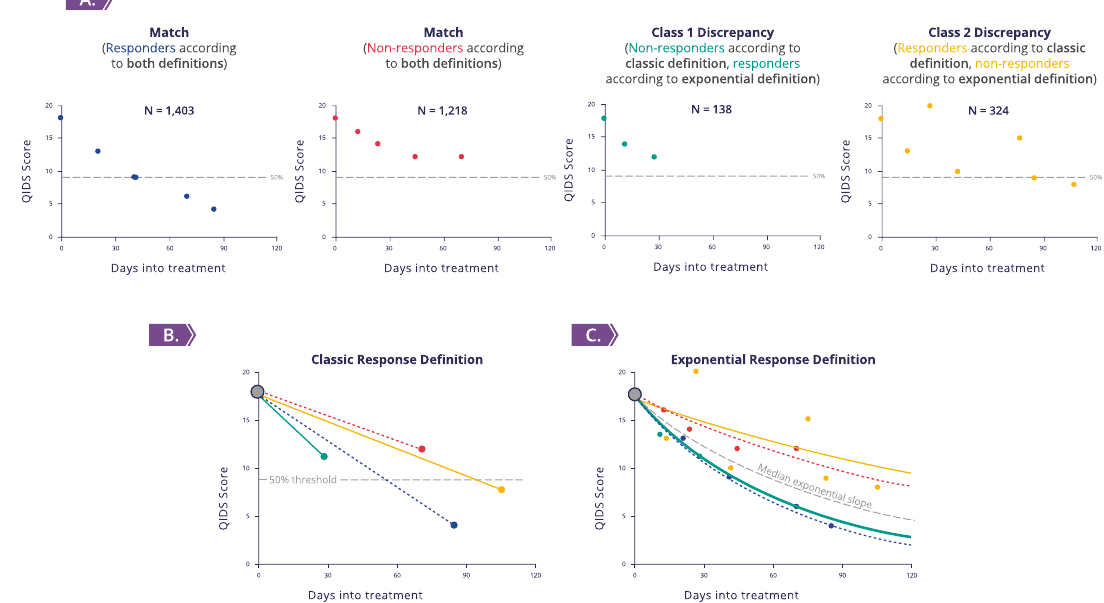
Fig. 1 Approaches for de fi ning response to antidepressants. A Four representative participants for the three classes of antidepressant response de fi nition approaches ’ comparison with their original trajectories: “ match ” class [blue and red, dotted in ( B , C) ] represents 85% of participants, class 1 discrepancy (turquoise) 4.5%, and class 2 discrepancy (yellow) 10.5%; added in N are the numbers of participants in each group. B Response trajectory for the three classes according to the classic de fi nition of 50% reduction in QIDS score (gray line). C Response trajectory for the three classes according to the exponential fi t de fi nition; participants with a slope steeper than the median (gray) are categorized as responders (blue and turquoise), and the rest (red and yellow) are categorized as nonresponders. [Both ( B , C ) include the time- points that were used in the calculation of the